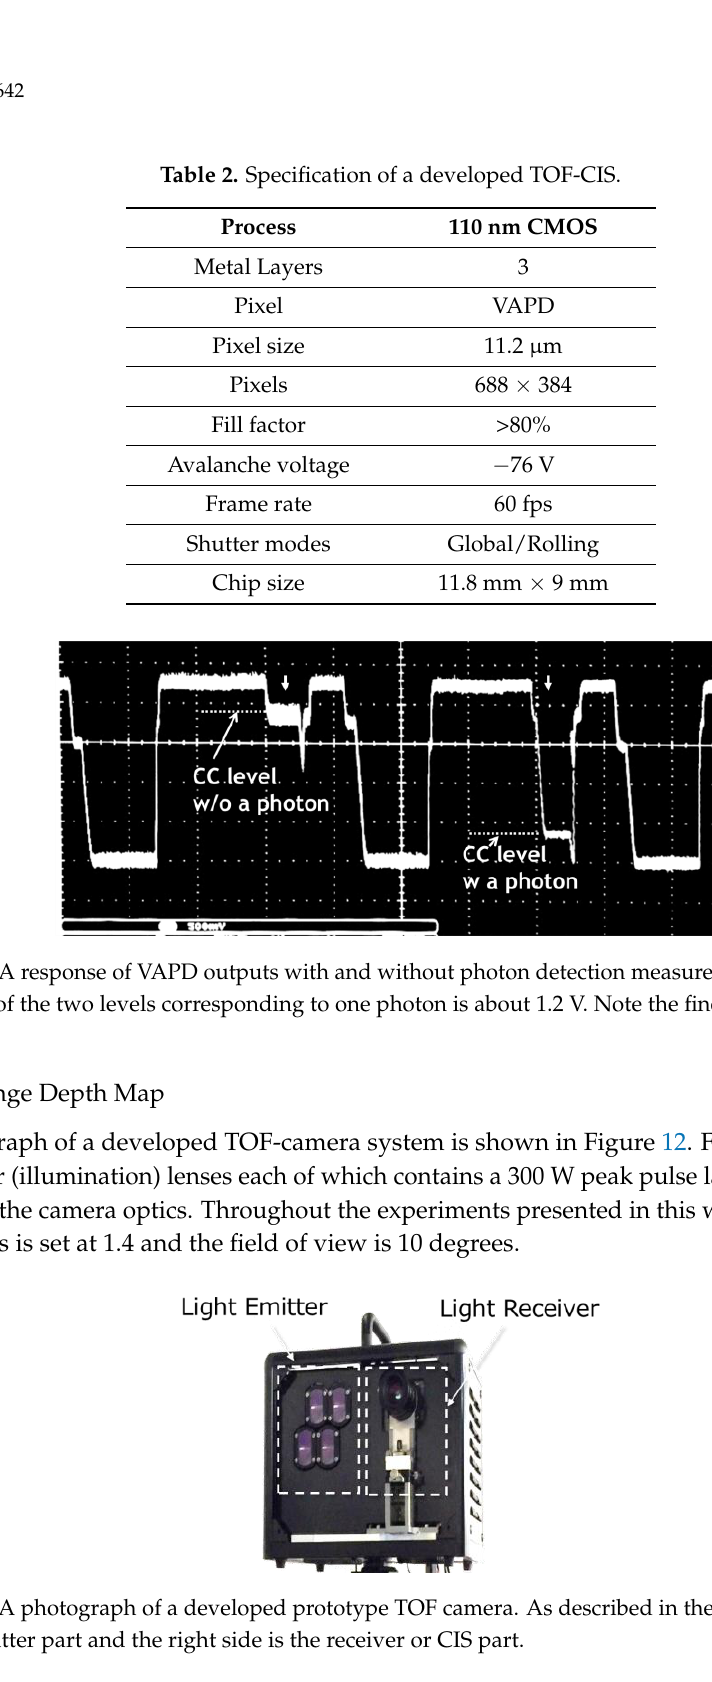
Figure 13. A schematic timing chart of important pulses used in the ranging experiment. The origin of time is only for convenience. The duration of laser pulse is 10 ns and the shape cannot be drawn with this scale. The results of the ranging experiments are shown in Figure 14. A photograph of a real dark scene taken by a digital camera is shown in the Figure 14a. For comparison, an intensity image taken by a VAPD CIS is shown in Figure 14b. Finally, a full range of 270 m depth map is obtained as shown in Figure 14c. We set six subranges, each of which is 45 m. In each subrange, we recognize a pedestrian in the first zone colored by blue, a street tree and a crosswalk colored by light blue, a cyclist on another crosswalk colored by light green, a street tree (left side) colored by yellow, and a car and a pole with 10 cm width colored by red or located at 250 m, thus demonstrating the initially specified target.